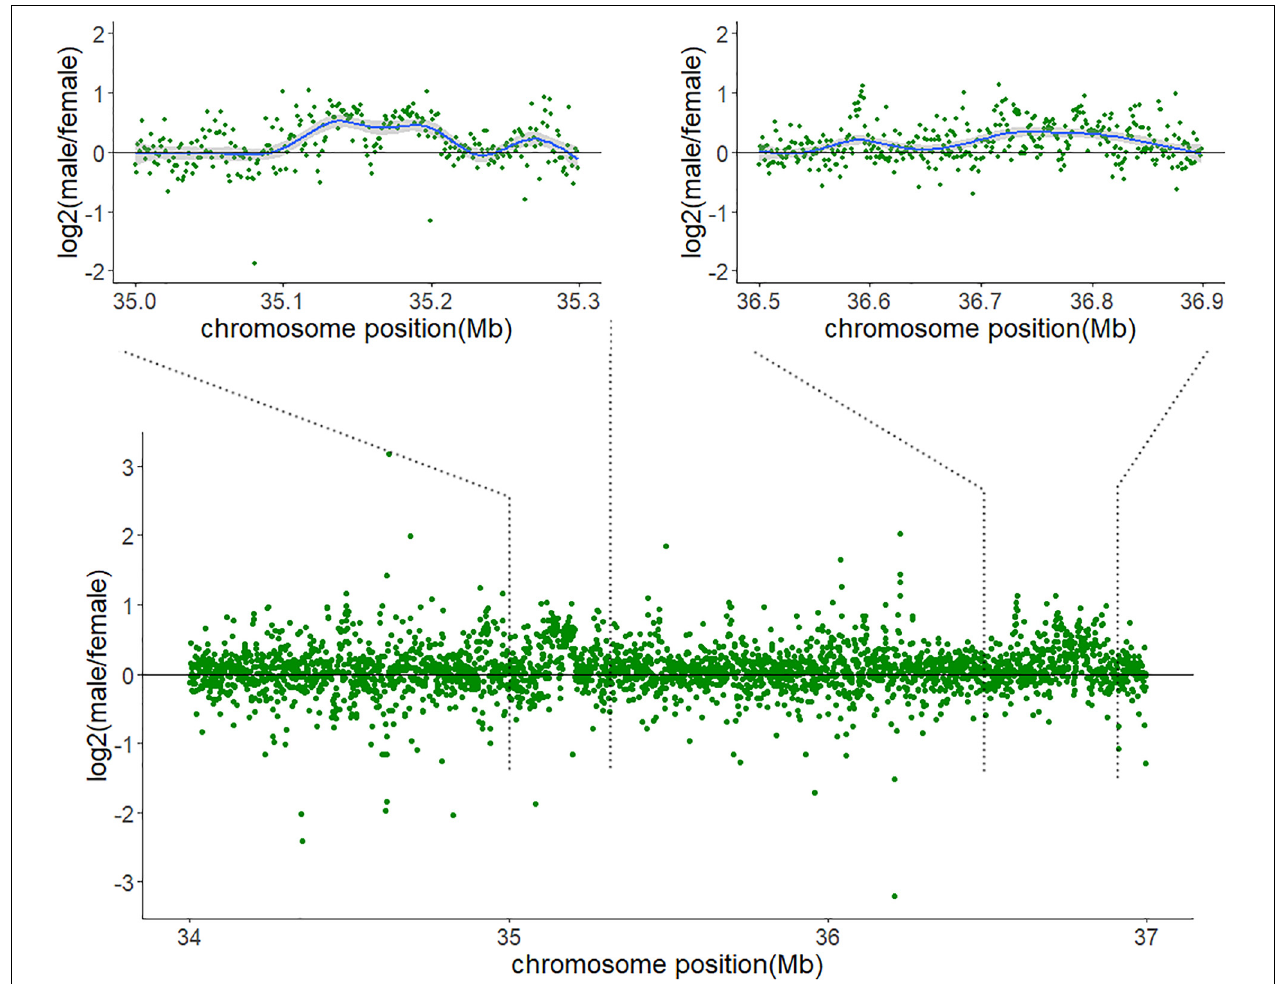
FIGURE 3 | Sequencing depth ratios of male to female in the 34–37 Mb interval of Chr7. The values of the read depth ratios are represented in